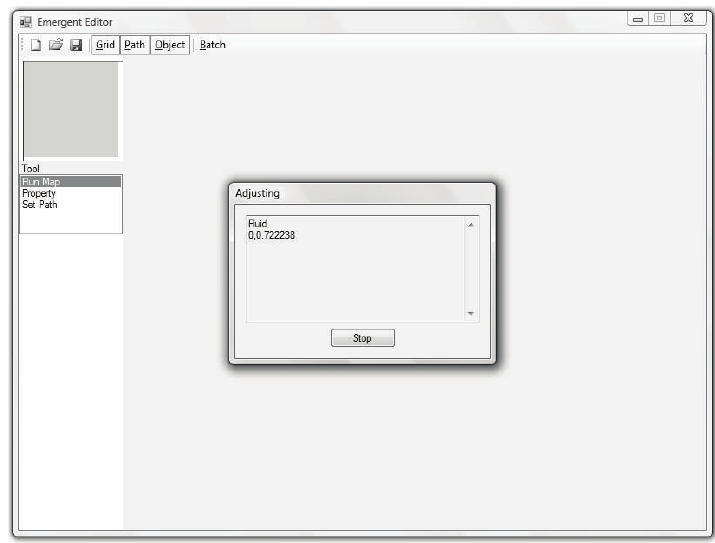
Figure 5: Automatic properties adjustment.